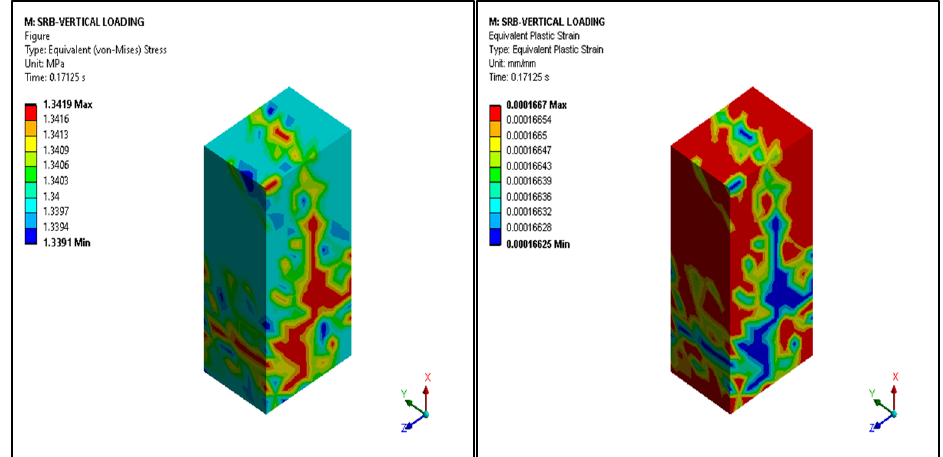
Figure 31. Total deformation of sustainable red mud bricks using ANSYS.